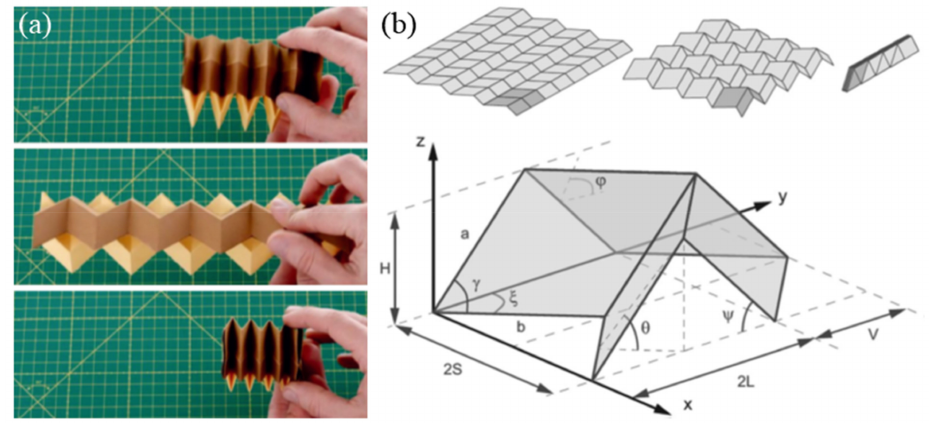
Figure 18. Origami metamaterials. ( a ) ‘zipper’-coupled tube system. ( b ) The geometrical design of Origami structure